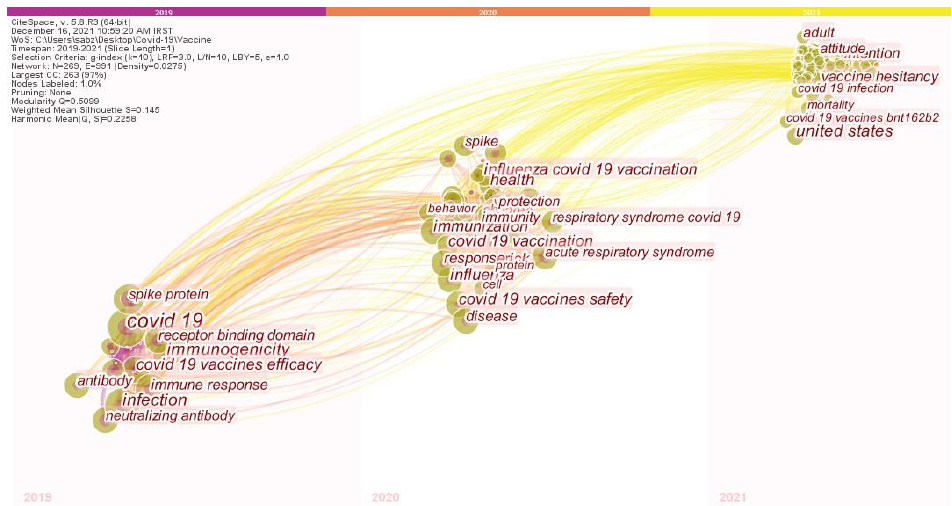
Figure 11. The time zone visualization map of co-occurring keywords in COVID-19 Vaccine research.